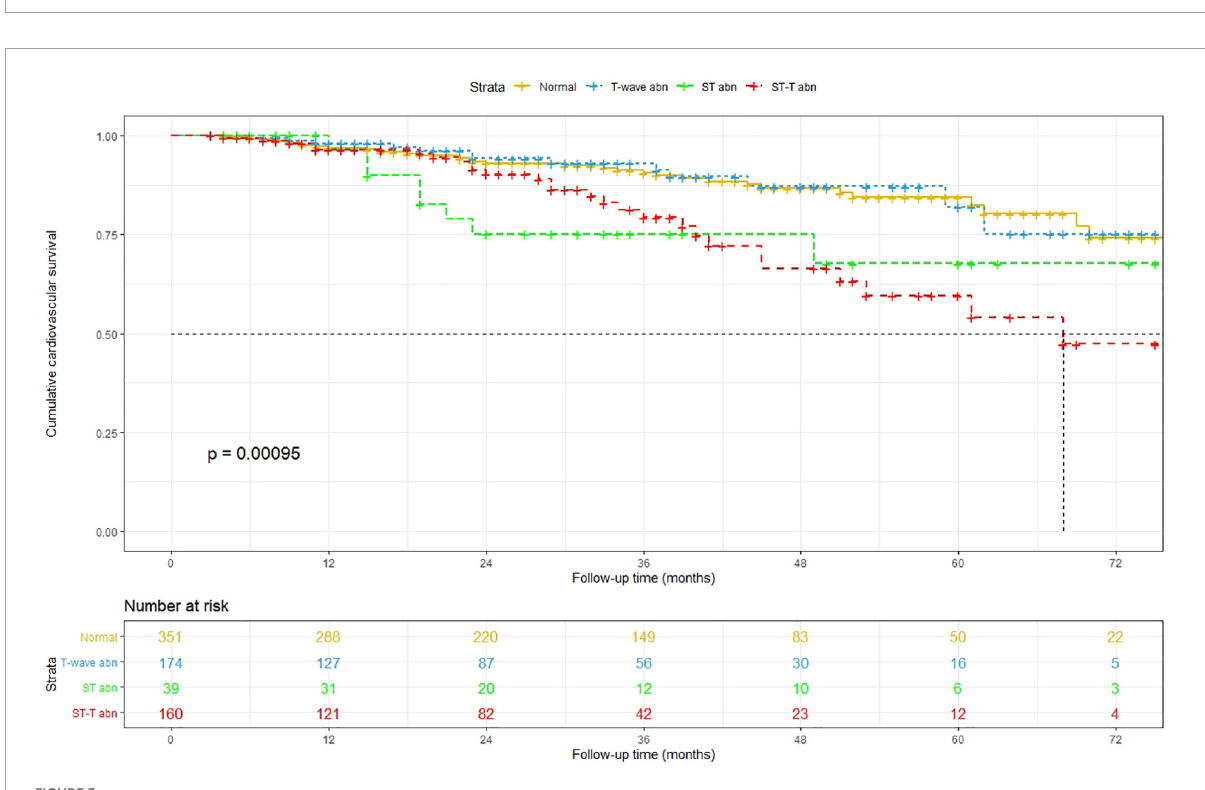
FIGURE3 Kaplan–Meier curves for the cumulative cardiovascular